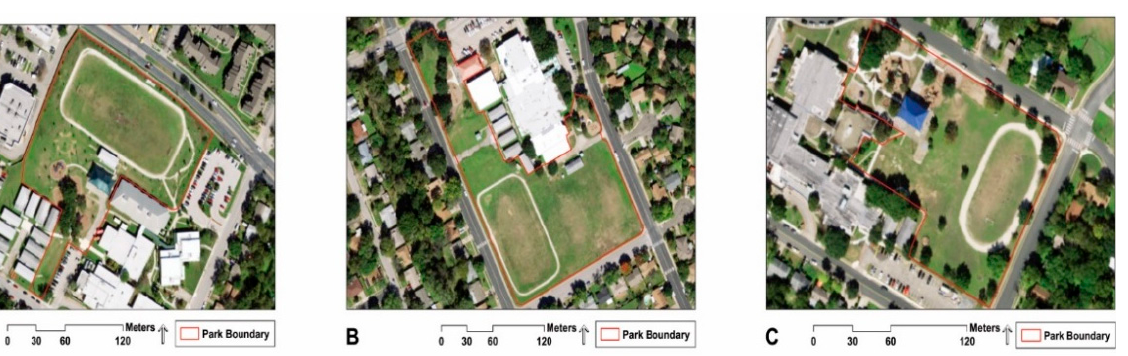
Figure 2. Daily trends in seven-day cumulative incidence rate of COVID-19 cases in Texas and the United States per 100,000 population [43]. During the 18 study days across September and November 2020, the COVID-19 or- ders in effect remained the same. On 14 August 2020, the Mayor of Austin extended the existing Stay Home, Mask, and Otherwise Be Safe order in Austin to 16 August–15 De- cember 2020. Specific to our focus on children and use of public parks, the order estab- lished all persons must practice social distancing—at least a six-foot distance from other individuals—except when in the presence of members in their own household, when passing someone is incidental and momentary, and when dining in groups of 10 or less. Second, the order established all persons must wear a face covering when outside their residence unless the person is younger than 10 years of age, or the person is engaging in physical activity outdoors and maintaining social distance from those in other house- holds. The order stated that parents and guardians of children younger than 10 were 050100 150200250 300350 400 7 - D a y C a s e s p e r 100 , 00 0 Texas